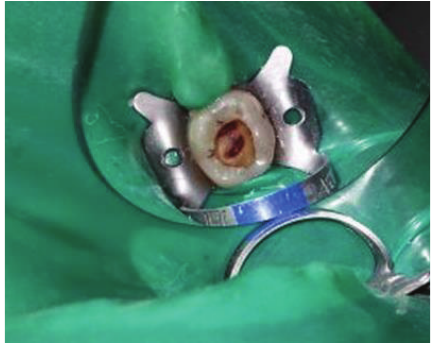
Figure 4: PRF membrane.